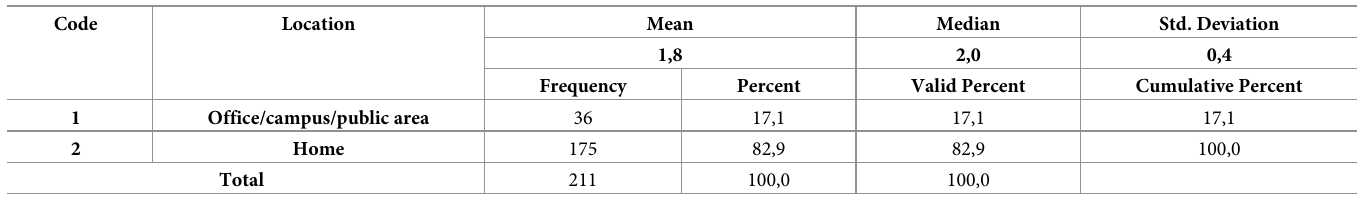
Table 9. Location accessing webinar.